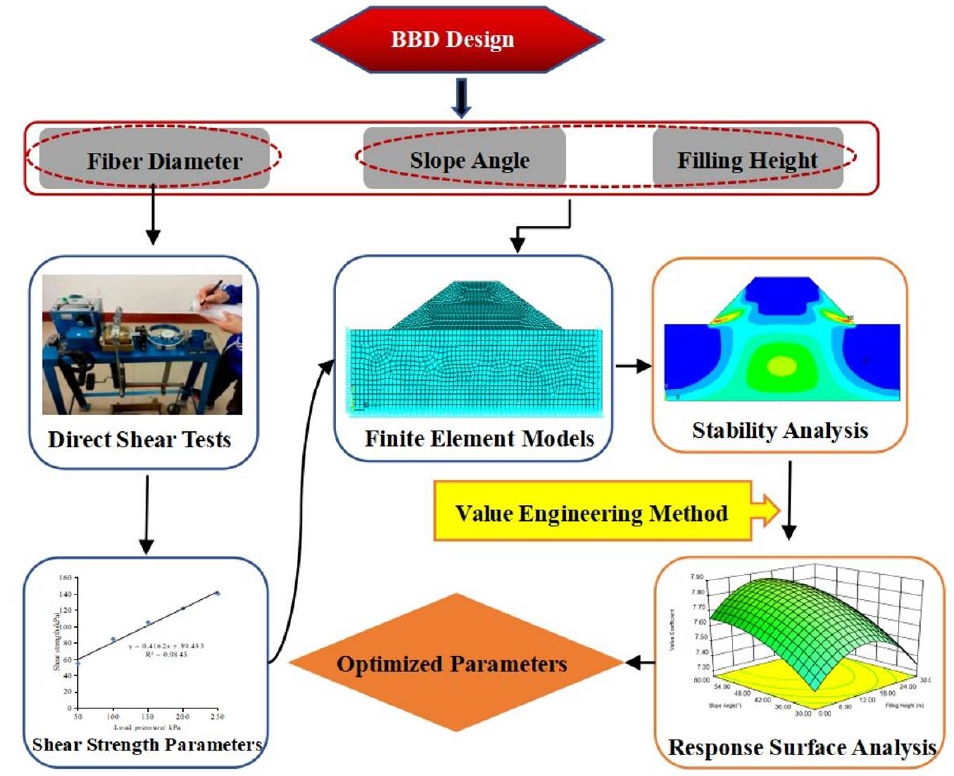
Figure 1. Technology roadmap.